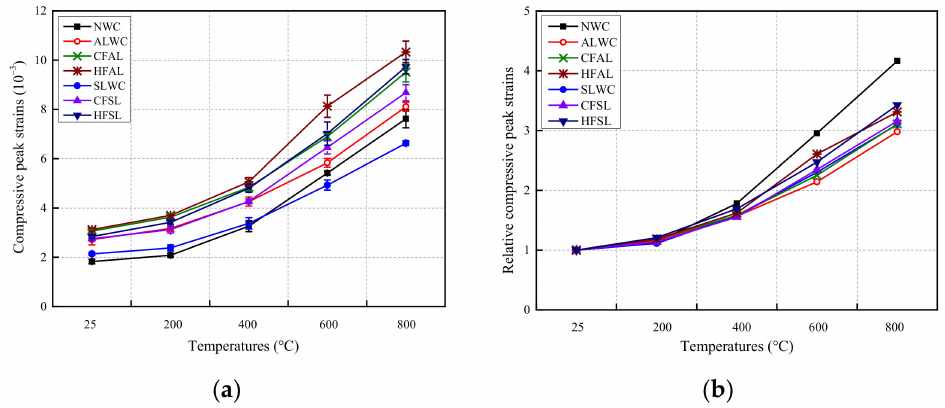
Figure 11. Temperature effect on compressive peak strains: ( a ) absolute compressive peak strains; ( b ) relative compressive peak